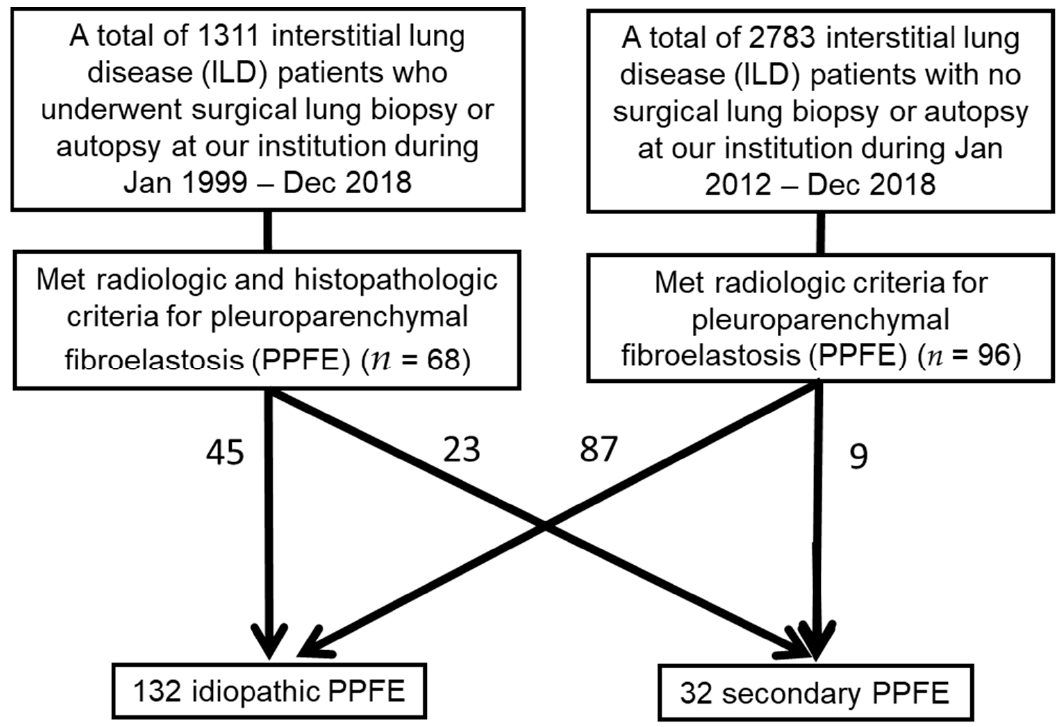
Figure 1. Flow sheet. ILD, interstitial lung disease; PPFE, pleuroparenchymal fibroelastosis. Individual differentiated connective tissue diseases, such as Sjögren’s syndrome, sys- temic sclerosis, and rheumatoid arthritis, were diagnosed using standard criteria [26–28]. HP was diagnosed based on the official criteria of the American Thoracic Society, the Japanese Respiratory Society, and the Latin American Thoracic Association clinical practice guide- line [29]. Clinical and laboratory data, pulmonary function test (PFT) data, and bronchoalve- olar lavage (BAL) fluid findings on initial examination were collected retrospectively from the medical records. Data regarding the clinical course of each patient after diagnosis, including complications and prognosis, were also